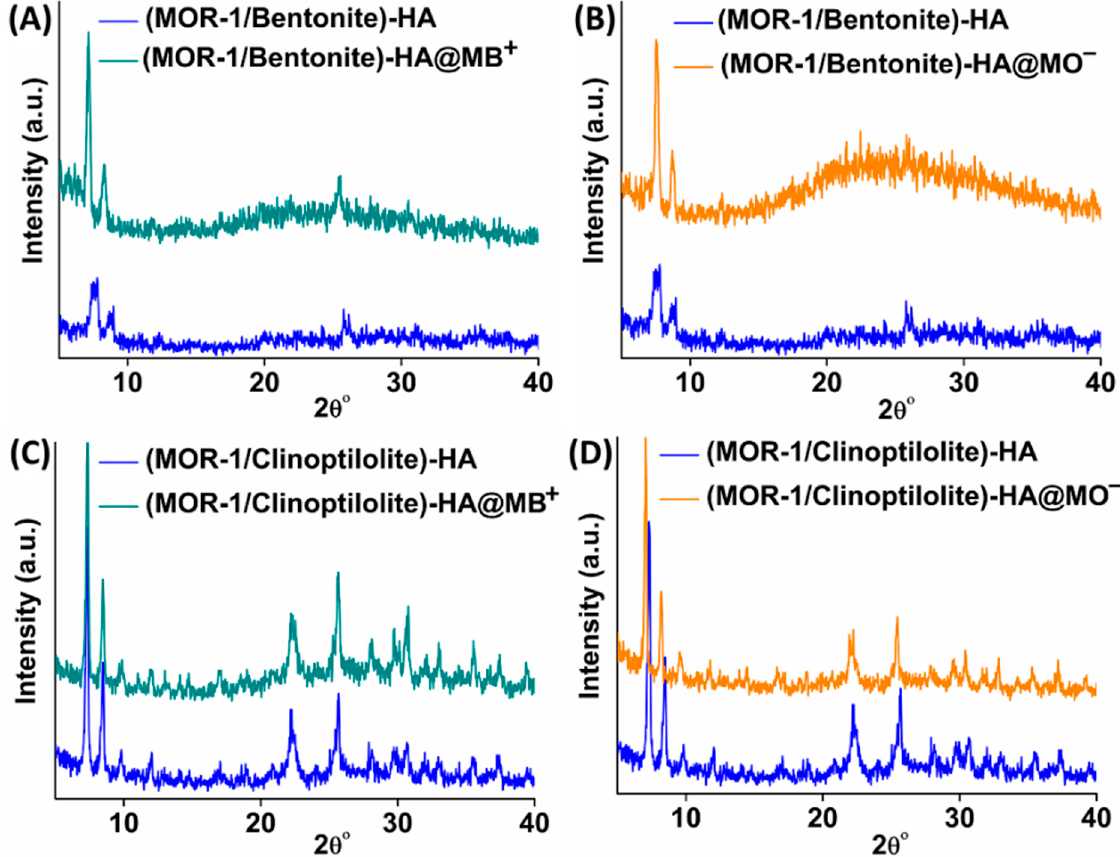
Figure 11. PXRD patterns of (MOR-1/Bentonite)-HA along with those of ( A ) (MOR-1/Bentonite)- HA@MB + , ( B ) (MOR-1/Bentonite)-HA@MO − and MOR-1/Clinoptilolite)-HA , ( C ) (MOR- 1/Clinoptilolite)-HA@MB + , and ( D ) ( MOR-1/Clinoptilolite)-HA@MO −